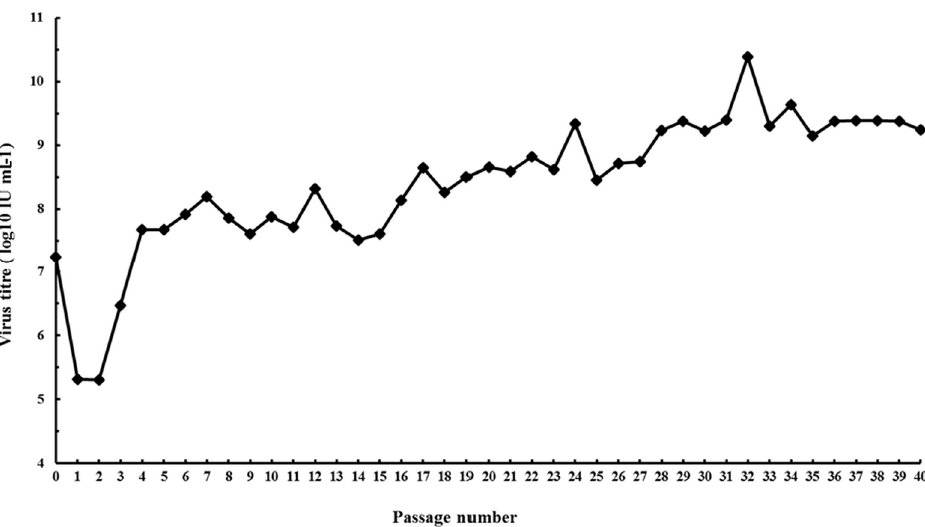
Figure 1. Serial passage of Modified vaccinia virus Ankara (MVA) (ATCC VR-1508) in human cell line. Caco-2 (ATCC HTB-37) cells were infected with purified MVA at a multiplicity of infection (m.o.i.) of 0.01 and the virus was blindly passaged in Caco-2 40 times. At each passage (three days post infection) infected cells were harvested, freeze-thawed three times and the virus titer was determined [52].